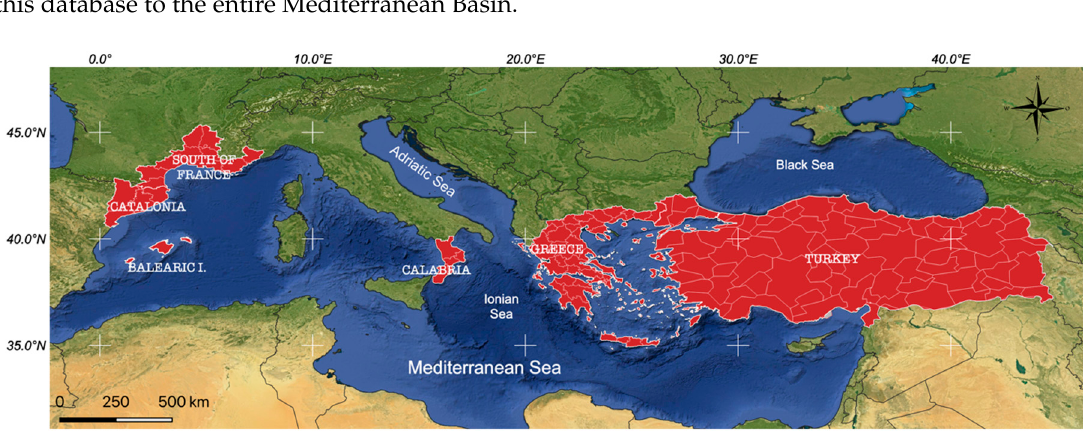
Figure 2. Countries / regions participating to the MEFF v2.0 Figure 2. Countries/regions participating to the MEFF v2.0 DB.